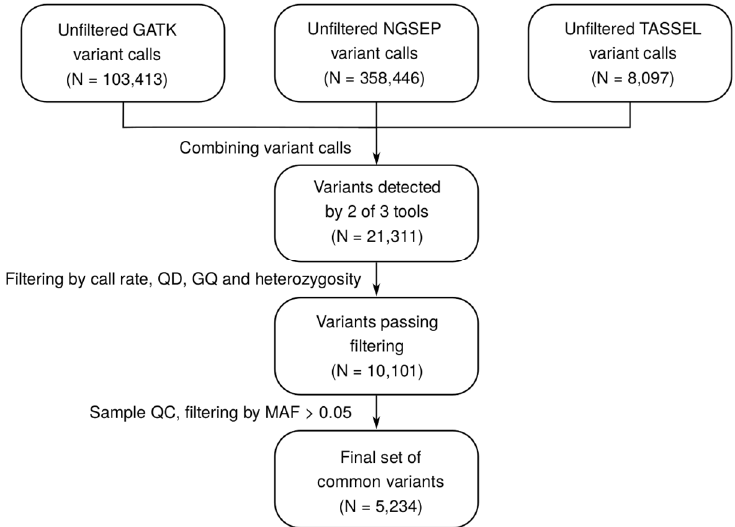
Figure 1. A workflow diagram describing the construction of a reference variant dataset for guar ( Cyamopsis tetragonoloba (L.) Taub.).